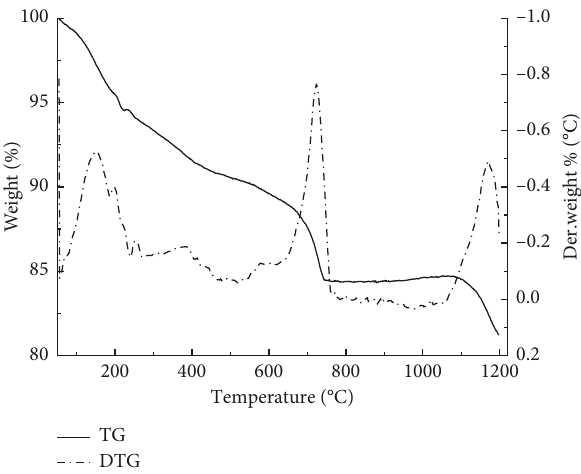
Figure 7: TG/DTA diagram of GP paste for curing